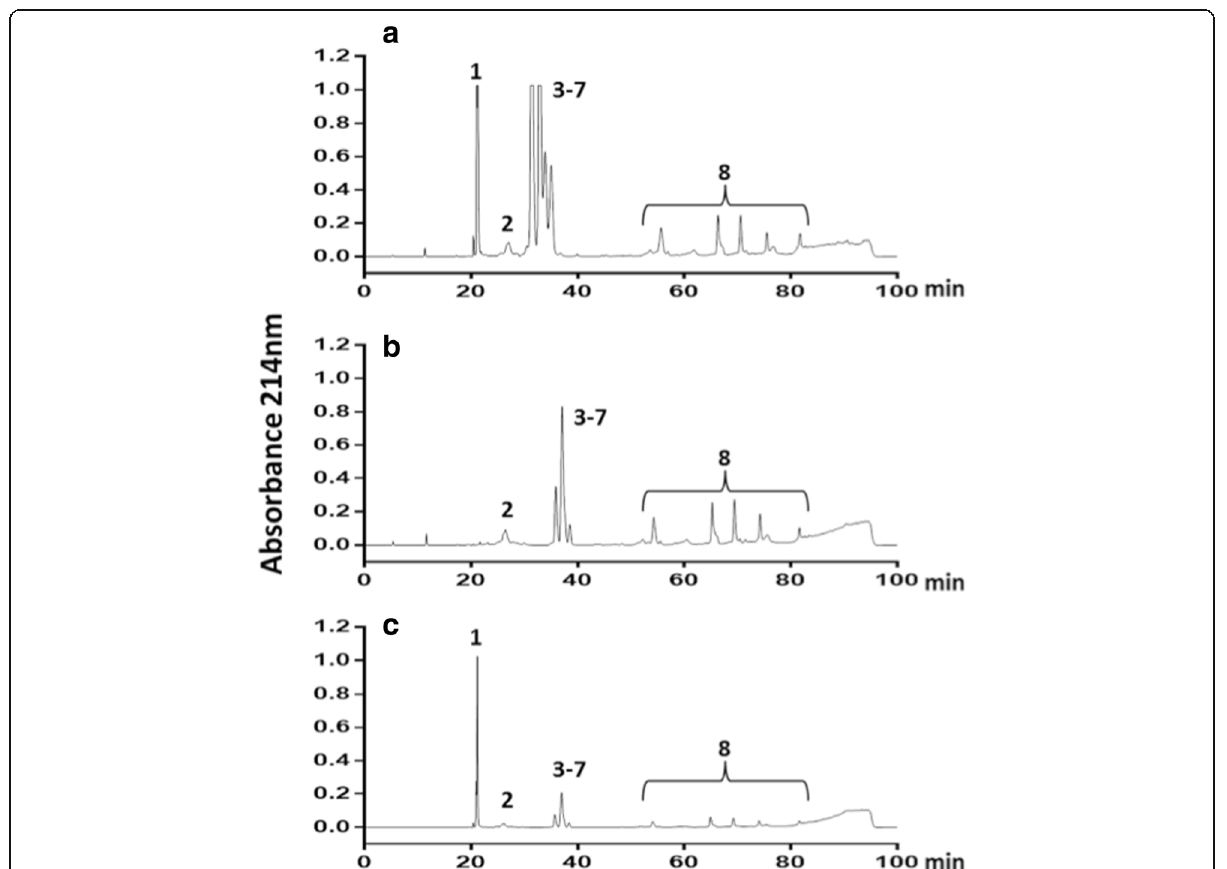
Fig. 1 Antivenomics analyses of crotalic antivenom manufactured by IVB. a About 300 μ g of crotamine-positive venom separated by RP-HPLC using second-generation antivenomics protocols [17]. The elution conditions were: isocratic gradient with 5% of 0.1% TFA in 100% of acetonitrile (solvent B) for 5 min followed by a 5 – 25% B for 5 min, 25 – 45% B for 60 min and 45 – 70% B for 10 min, with a final isocratic step of 70% B for 5 min at a flow rate of 1 mL/min. b and c the RP-HPLC profiles of retained and non-retained venom toxins on anticrotalic (batch SAC085204b) affinity column, respectively. Protein families associated with HPLC peaks: 1 – crotamine, 2 – disintegrin, 3 – 7 – crotoxin, and 8 – fractions of low expression toxins including D49-PLA 2 , serine protease (gyroxin), C-type lectin (convulxin) and